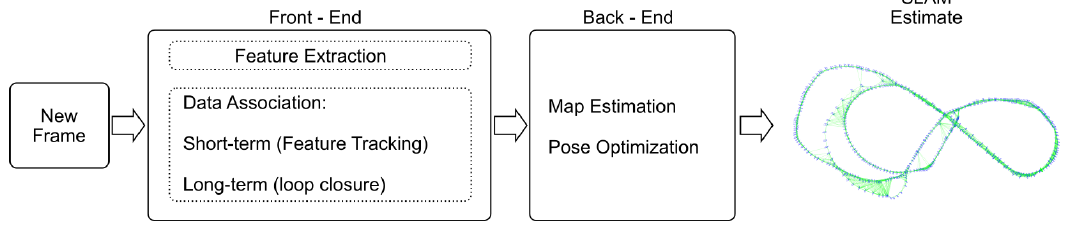
Figure 1. Simplified vSLAM